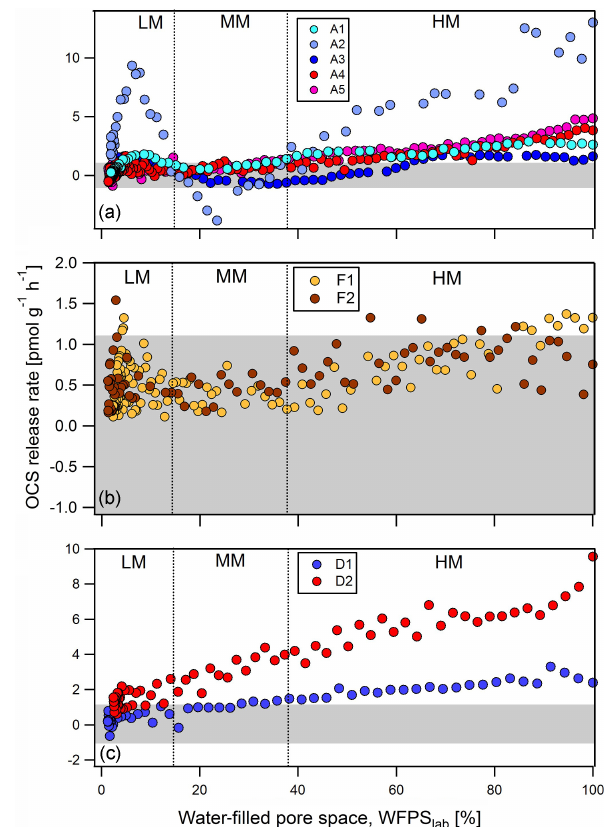
Figure 1. OCS exchange rates from soil samples originated from agriculture (a) A1 to A5: cornfield (light blue), cornfield (blue), sugar beet (dark blue), wheat field (red), and grassland (pink); (b) F1, F2: natural rainforest (orange) and annual burned rainforest (brown); and (c) D1, D2: sand desert (blue) and sand desert (red) measured at 500pptOCS mixing ratio and 400ppmCO 2 mixing ra- tio. According to Bunk et al. (2017) OCS release rates are classi- fied into high-moisture (HM), moderate-moisture (MM), and low- moisture (LM) regime. The y axis has different scales in subfigures. Data of A1, A2, and A3 are adapted from Bunk et al. (2019). Grey shaded area represents the threshold of 1.09 to − 1 . 09pmolg − 1 h − 1 where no significant OCS exchange could be